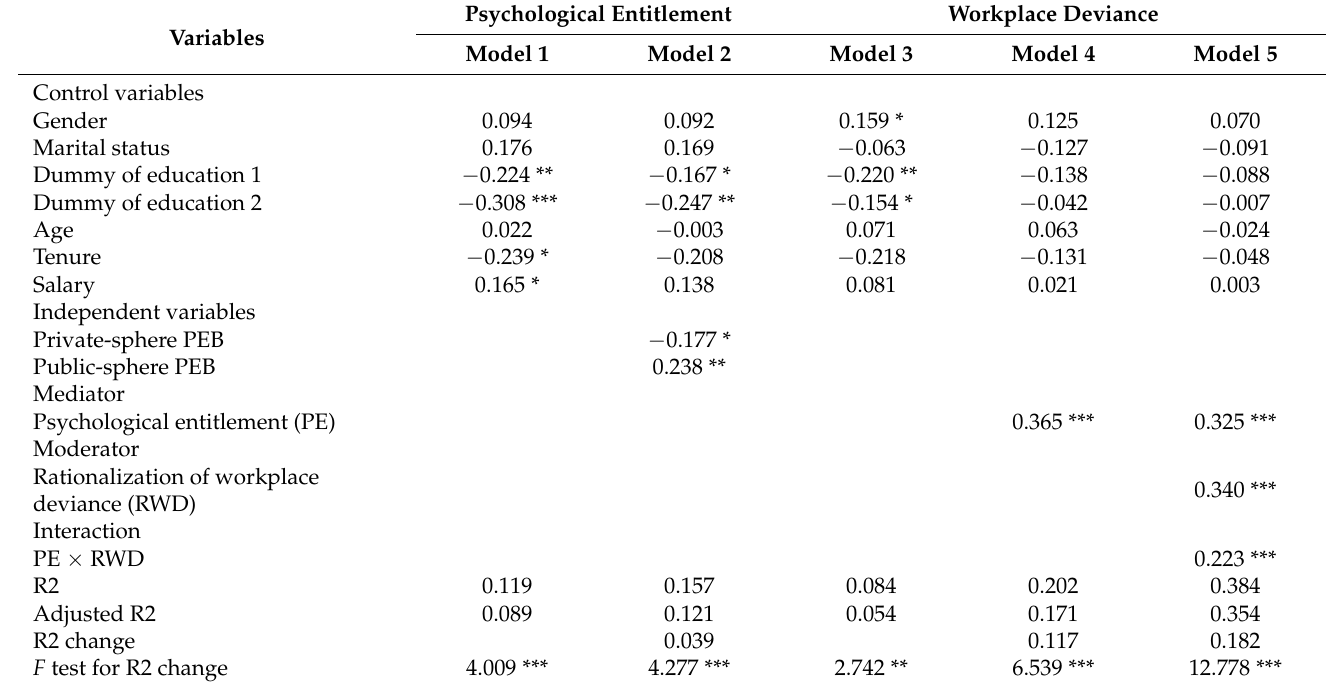
Table 3. The results of regression